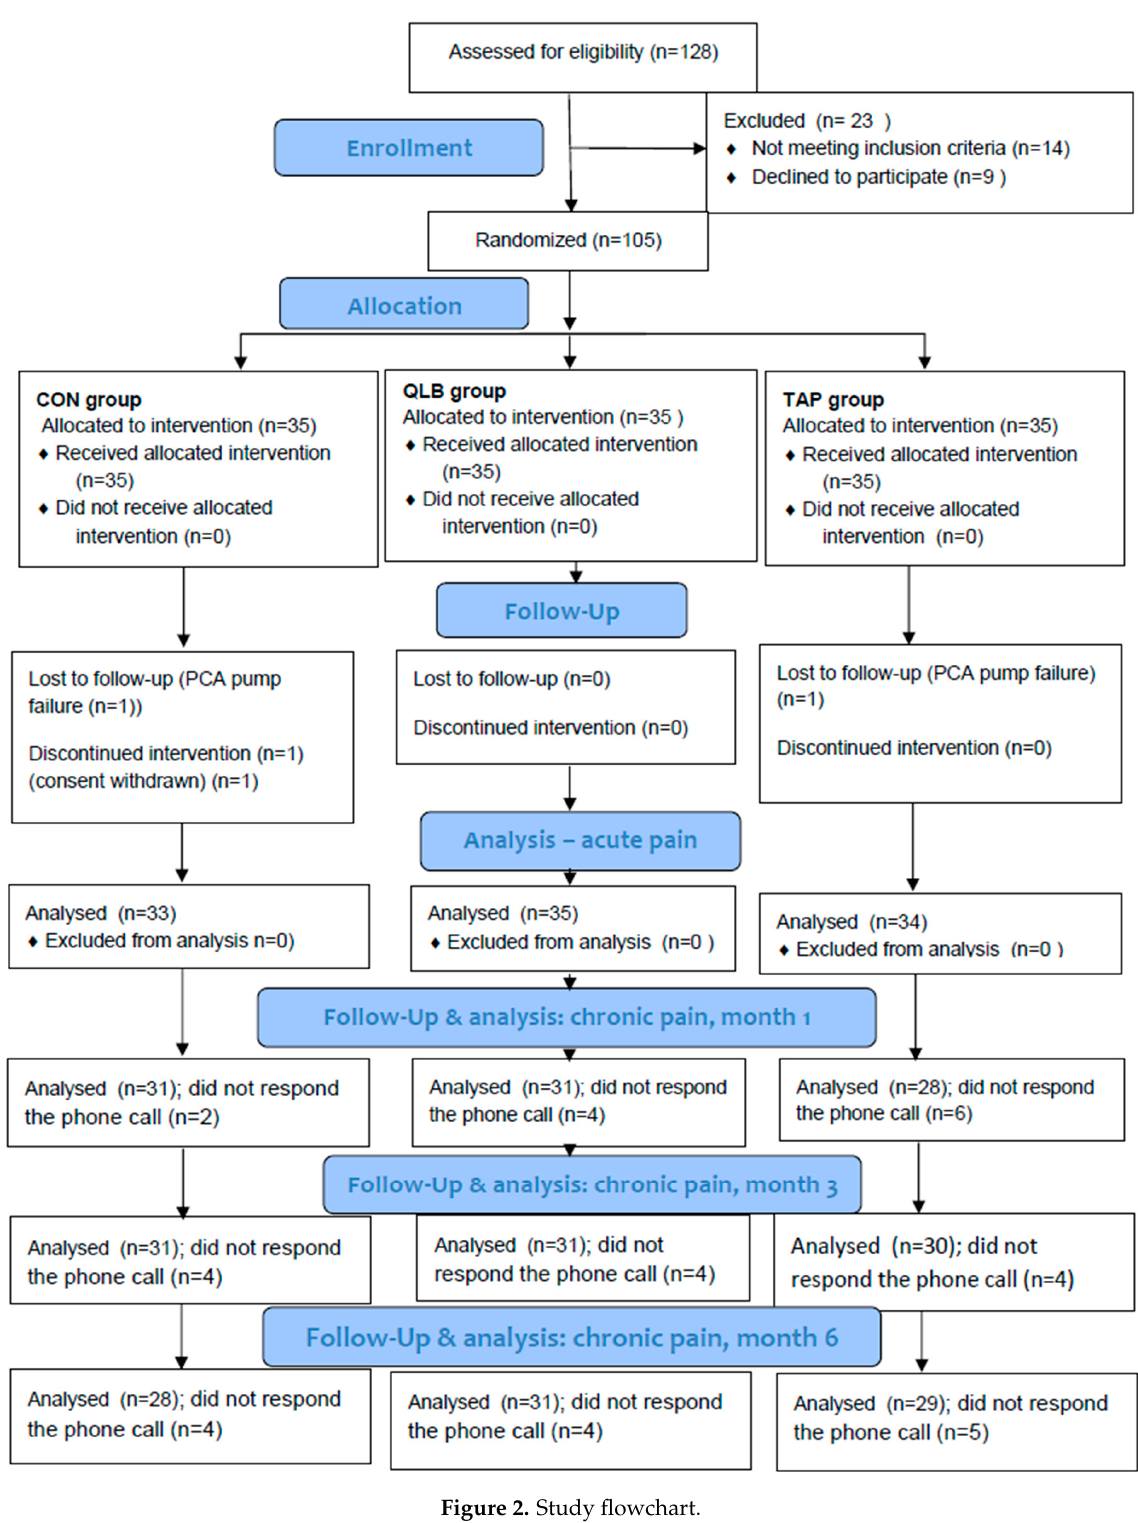
Figure 2. Study flowchart.